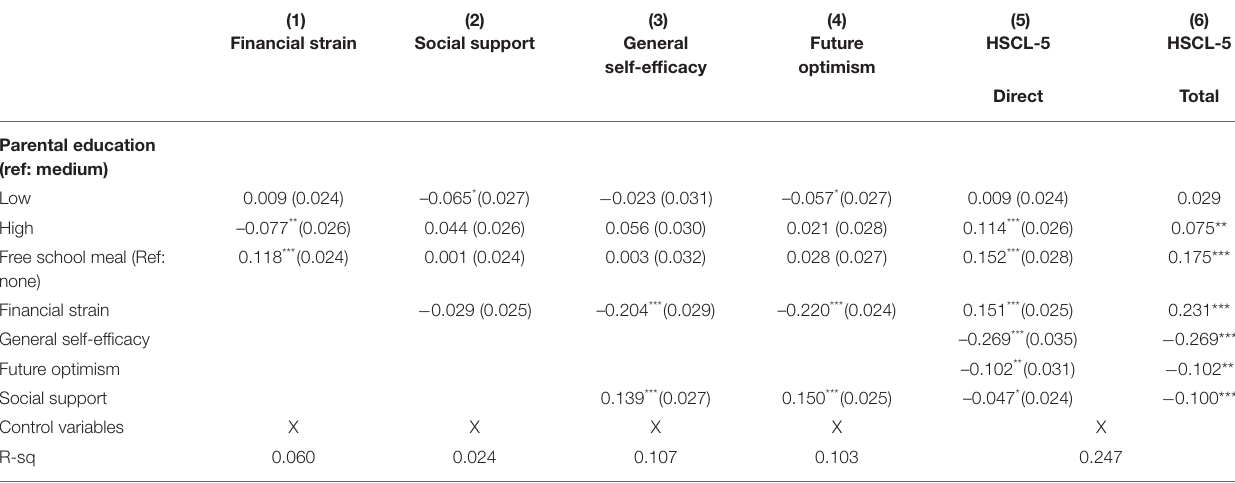
TABLE 2 | Pathways linking SES, financial strain, psychosocial resource factors and mental distress ( N = 2,402, Overall R-Sq. + 0.21, SRMR =